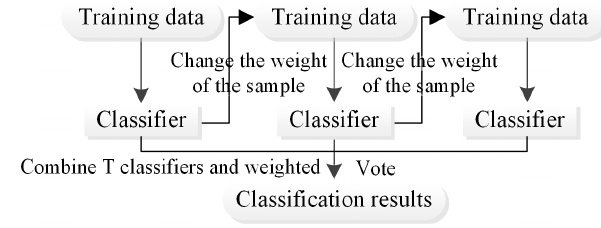
Figure 6. Flowchart of the boosting method .